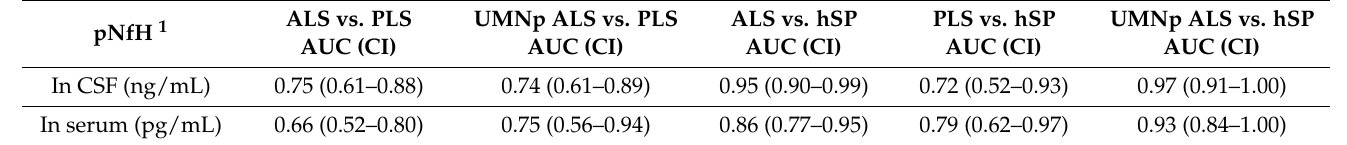
Table 4. Receiver operating characteristic curves for serum and CSF pNfH for discriminating ALS from other UMN syndromes. ALS vs. PLS pNfH 1 In CSF (ng/mL)